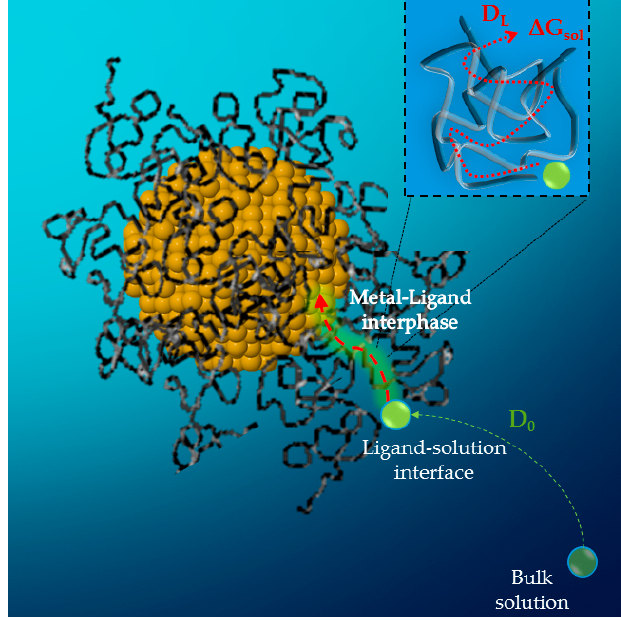
Figure 13. The diffusion process outside and inside the metal ‐ ligand interphase.